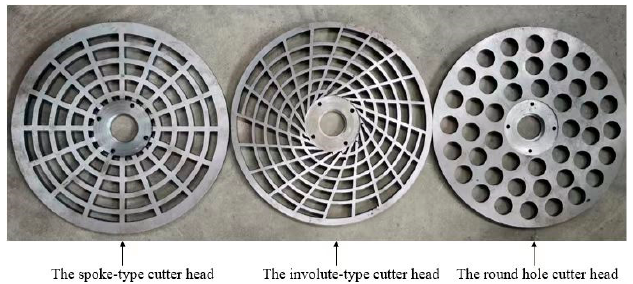
Figure 5. Three designed cutter heads.